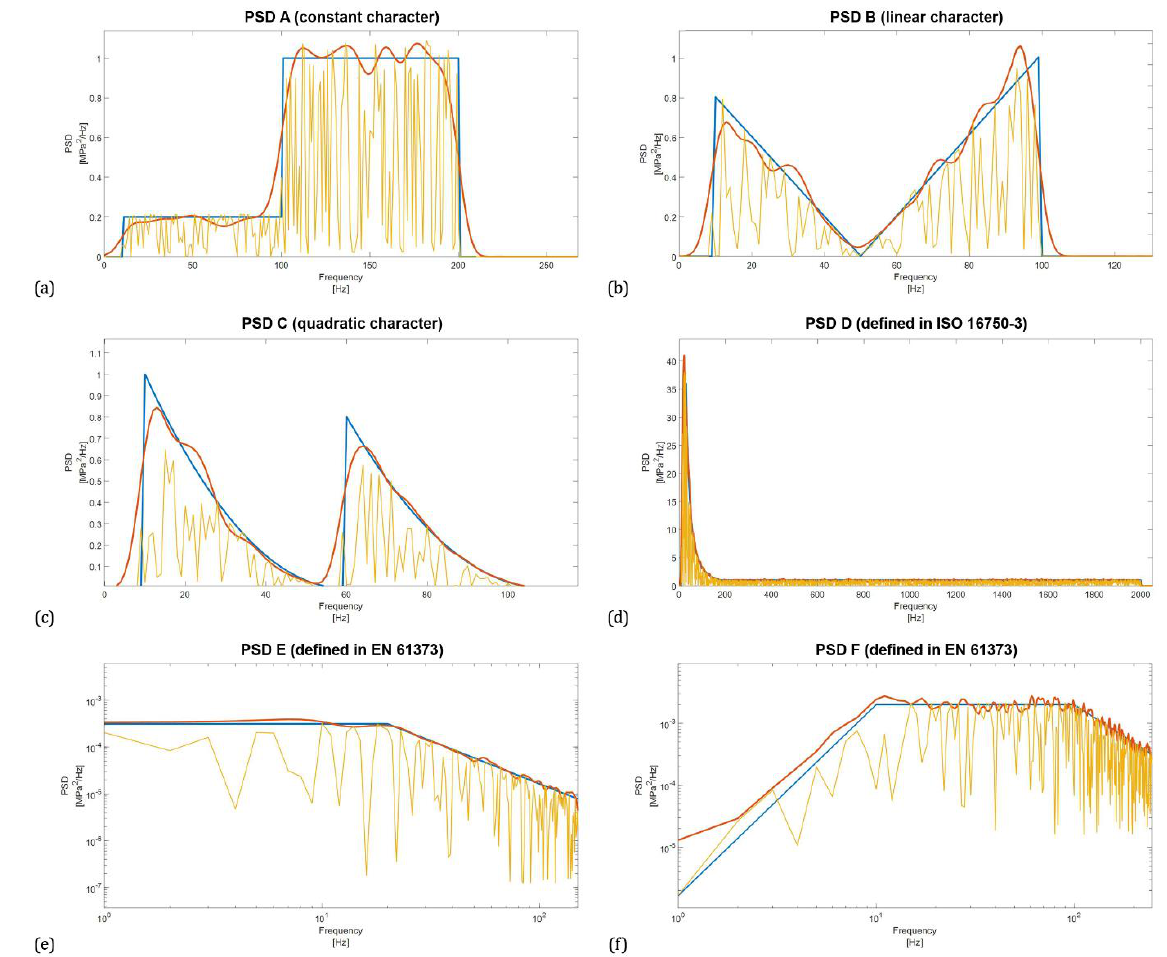
Figure 5. Comparison of PSDs calculated with different window size and overlay using Hamming window, blue line represents the reference PSD, red is for window size 20% and overlap 90%, yellow is for window size 85% and the overlap 25%. Comparisons prepared according to PSD using constants (a), constants with linear connection (b), constants with quadratic connection (c), standardized PSD functions according to ISO 16750-3 (d) and EN 61373 (e)-(f).